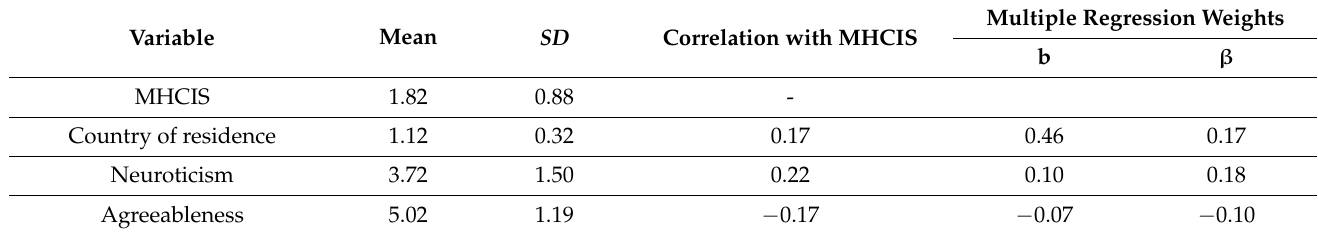
Table 3. Stepwise MRAs Results ( n =